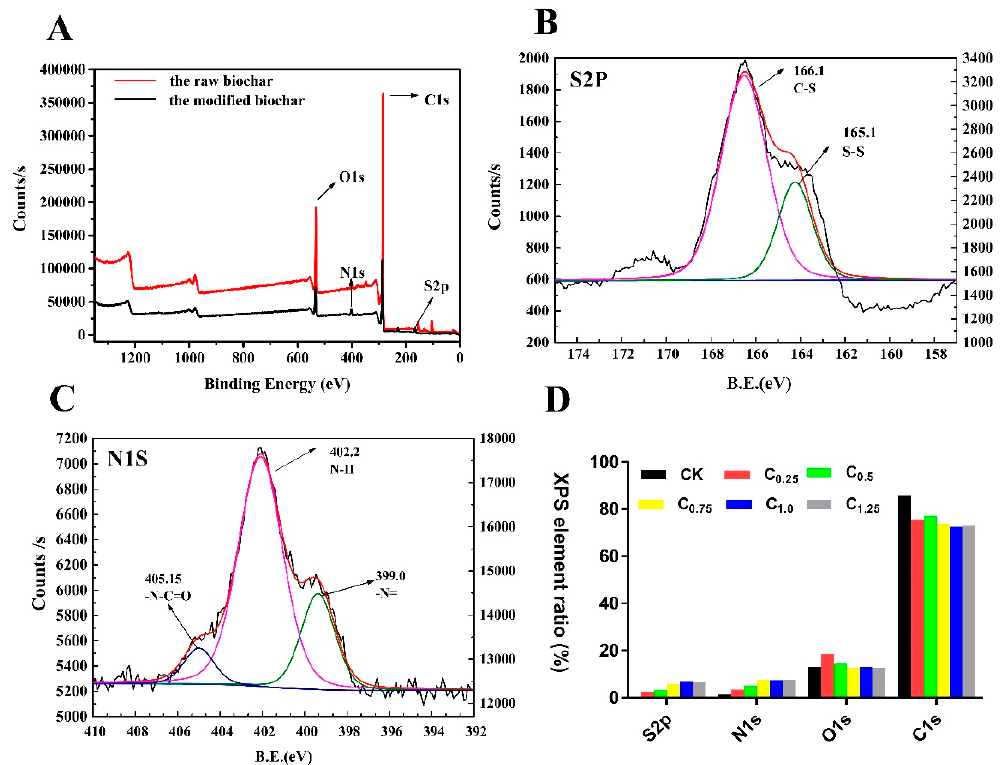
Figure 4. X-ray photoelectron spectroscopy (XPS) of raw and cystamine-modified biochars: ( A ) total, ( B ) S2P, ( C ) N1S, ( D ) surface element ratio.